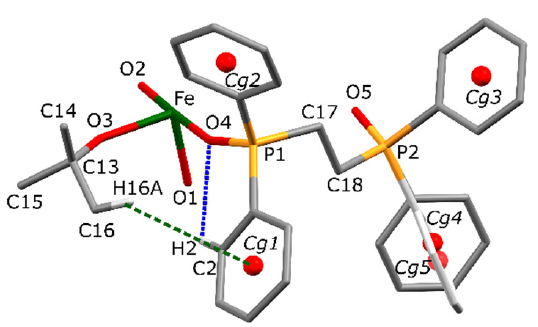
Figure 2. Selected short intramolecular interactions stabilizing the conformation of the cation of I . CH ... O type hydrogen bond (blue dotted line) and CH ... π interactions (green dotted lines). Hydrogen atoms not involved in particular interactions are omitted for clarity. Cg n represents centroids of phenyl rings. Cg 4 and Cg 5 refer to two sites of the disordered phenyl fragment. Only a symmetrically independent part of the molecule is presented.